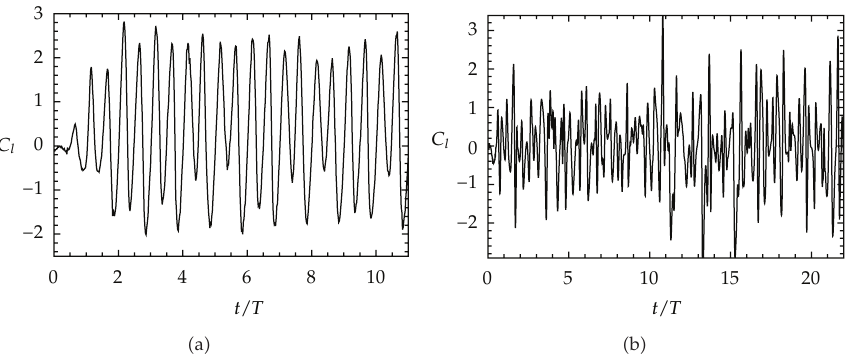
Figure 11: Time histories of C l of the first cylinder at KC (cid:8) 5 and